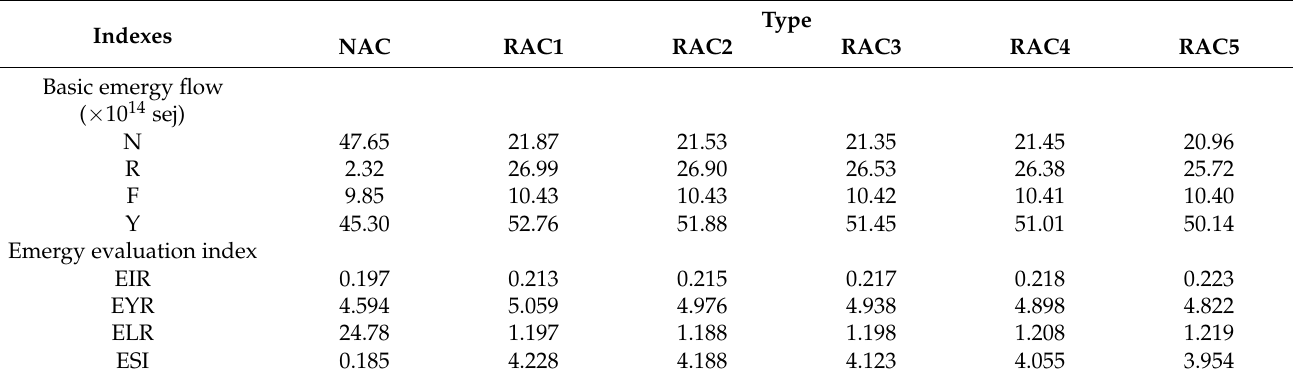
Table 8. Emergy indexes for sustainable analysis of NAC and